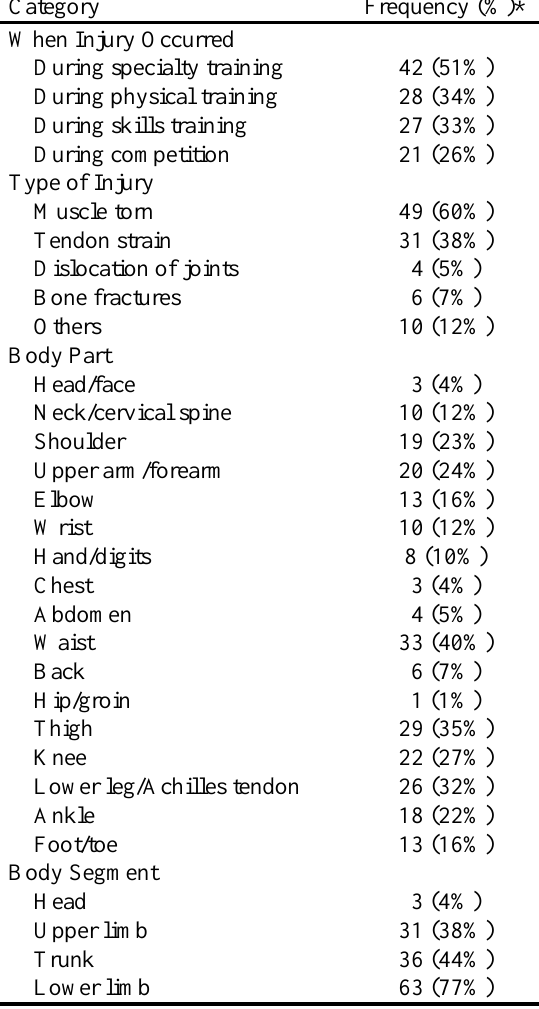
Details on the Injuries (n =